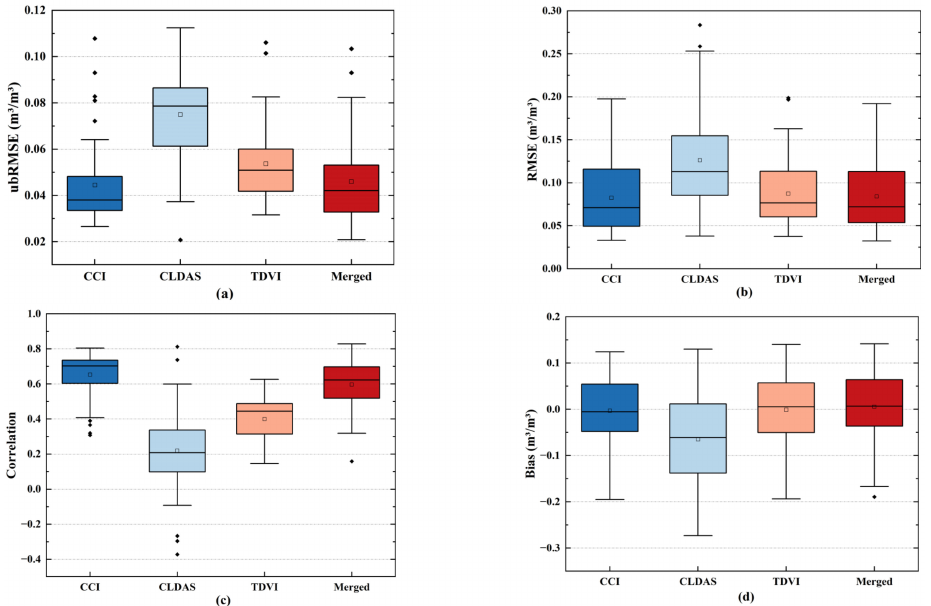
Figure 9. Comparison of statistical metrics (( a ) ubRMSE, ( b ) RMSE, ( c ) Correlation, ( d ) Bias) among ESA CCI combined, CLDAS, TDVI-based, merged SM in validation with the in situ measurements.